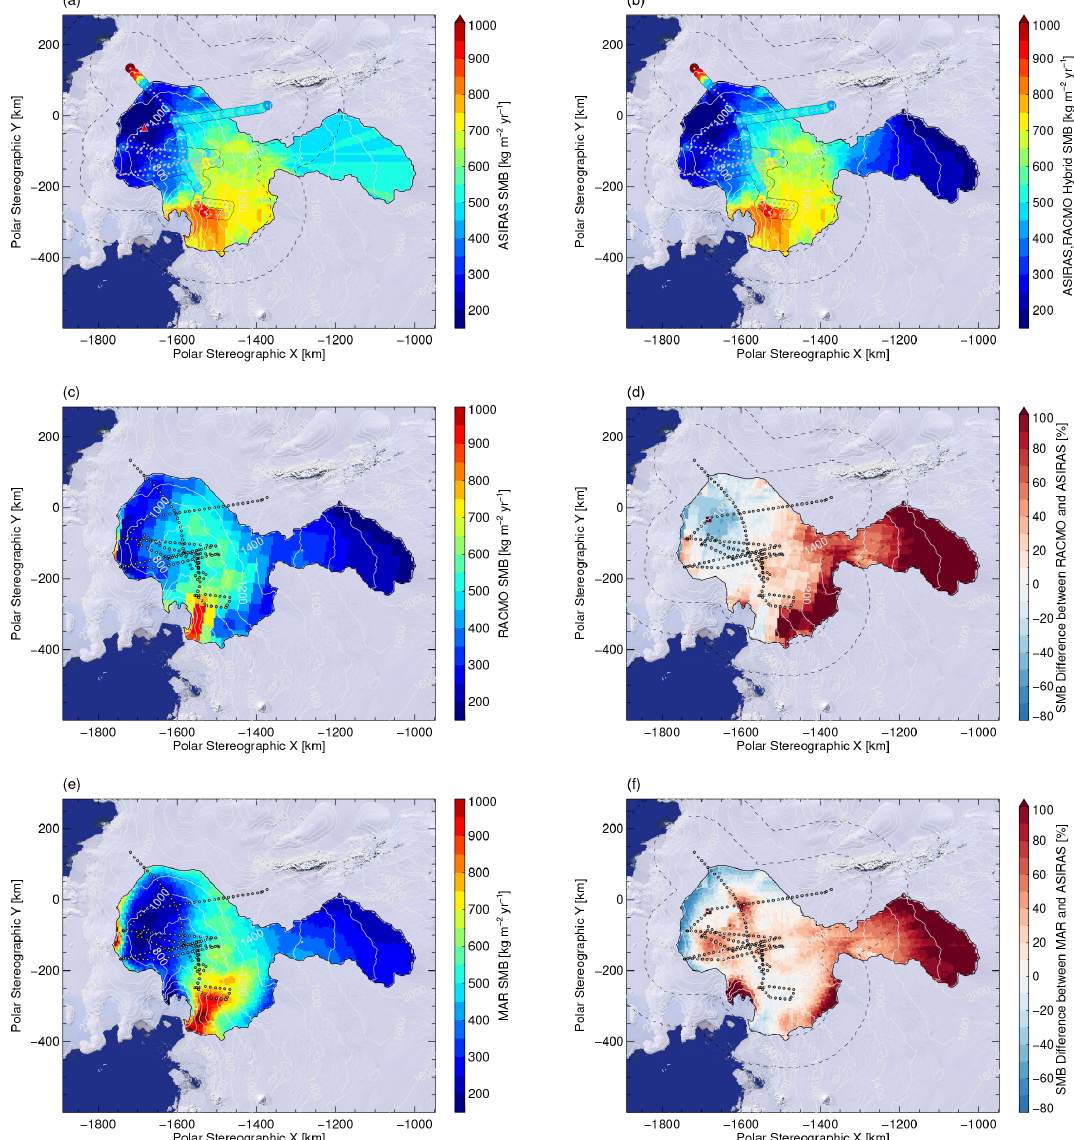
Figure 8. (a) ASIRAS annual mean SMB OLK estimates between November 2004 and December 2014. Measurement points colour coded with the same SMB scale. Red triangle denotes the position of an interpolation artefact (see Sect. 4.5). (b) Hybrid SMB map with ASIRAS estimates (a) linearly relaxing into RACMO SMB estimates (c) , which have been extracted for the same averaging period. Dashed lines denote the 100 and 190km maximum distance to the ASIRAS estimates and confine the transition zone between ASIRAS- and model-based SMB estimates (a, b, d, f) . (d) Relative SMB change from RACMO to ASIRAS, i.e. [ ( a ) − ( c ) ] /( c ) × 100. (e, f) MAR SMB fields and relative difference to ASIRAS by analogy with panel (d) . Background imagery taken from U.S. Geological Survey (2007) for all